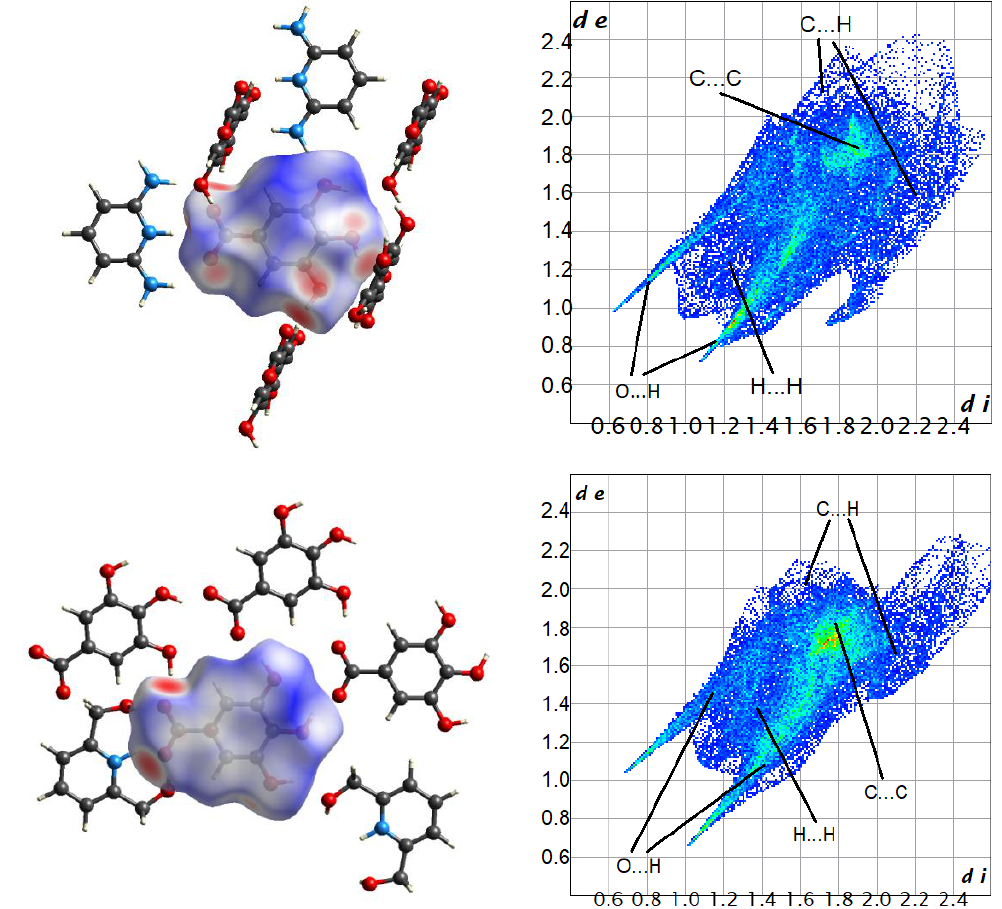
Figure 5. Hirshfeld surfaces (left) of the gallate anion in salts 4 (top) and 5 (bottom) and their 2D fingerprint plots (right) as generated by Crystal Explorer [83]. For the second symmetry-independent gallate anion in 4 , see Figure S10 of SI.